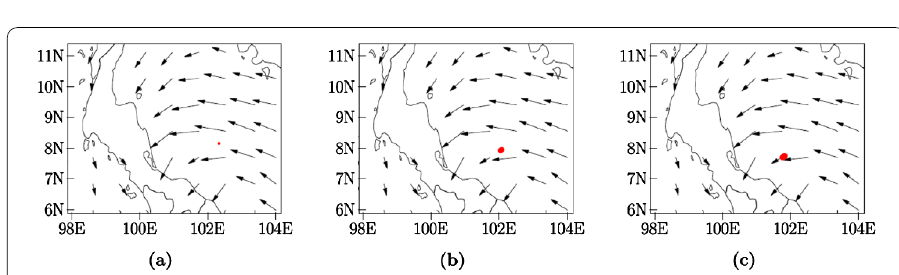
Figure 3 Movement of oil at Bongkot 23. The movement of oil slick (red dots in elliptical shape) at South Bongkot 23 oil drilling rig. ( a ) at the beginning of incident, ( b ) 30 minutes later, and ( c ) 60 minutes later.